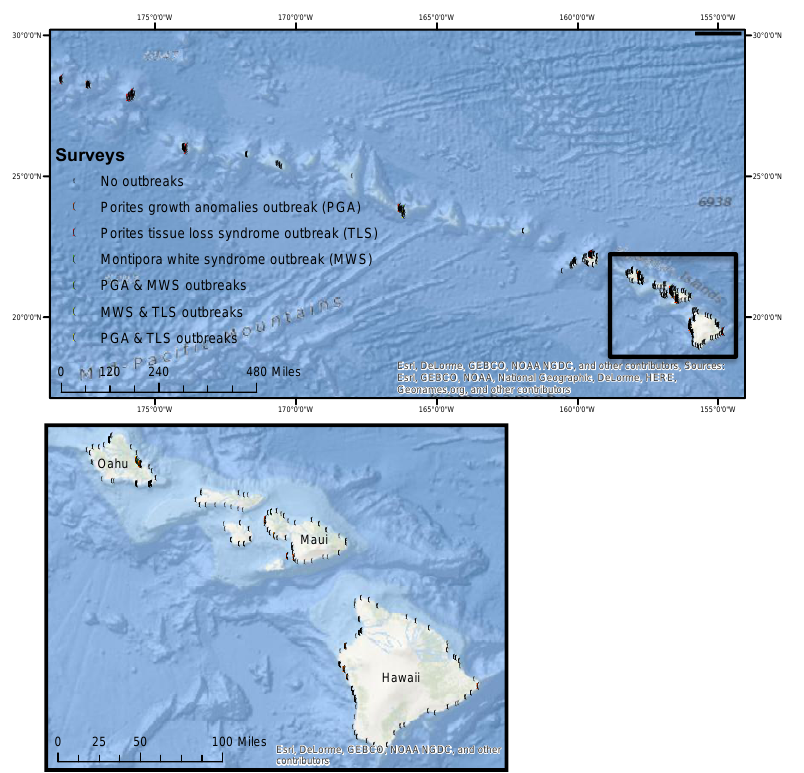
Figure 1. Map of disease surveys in the Hawaiian archipelago. Survey locations (dots) between 2004 and 2015 were along the extent of the archipelago. Colored dots indicate locations where an outbreak occurred. Table 1. Host distribution and environmental predictor variables used in boosted regression trees. Variable Total coral